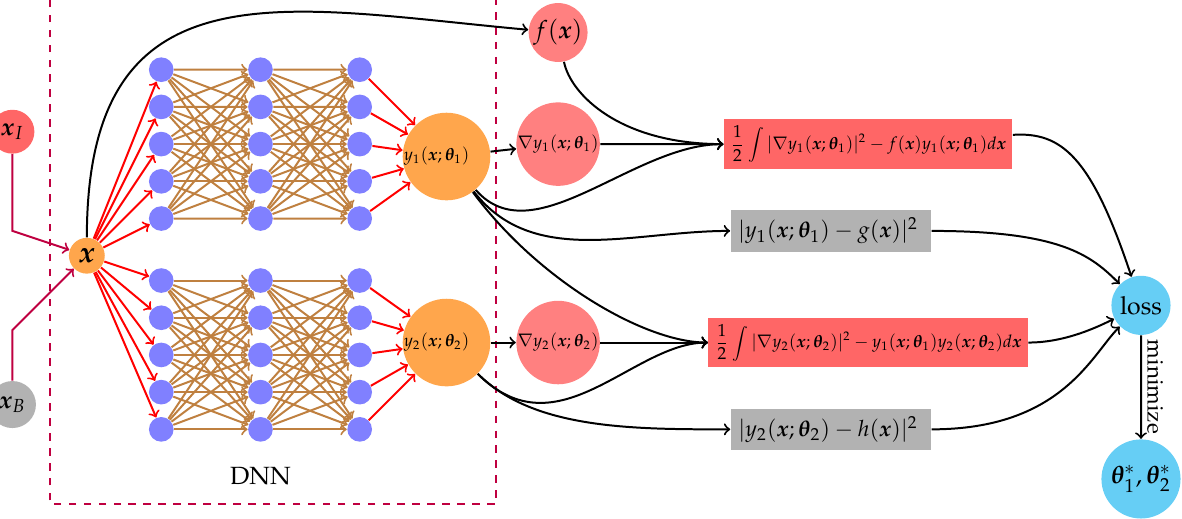
Figure 2. Schematic of a CDNN for solving the biharmonic equation. The left two DNNs with the same framework(dotted line box) share the input x ∈ R d (including x I and x B ), and the upper and lower branches output y 1 ( x ; θ 1 ) ∈ R and y 2 ( x ; θ 1 ) ∈ R , which are used to approximate the function w and u , respectively. The right part handles the outputs of DNN and forms the total loss according to PDEs constraints and boundary